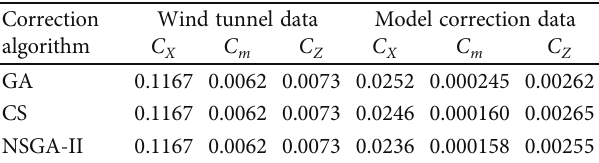
Figure 14: The MSE change with the number of generations: (a) C Table 2: The MSE results of di ff erent